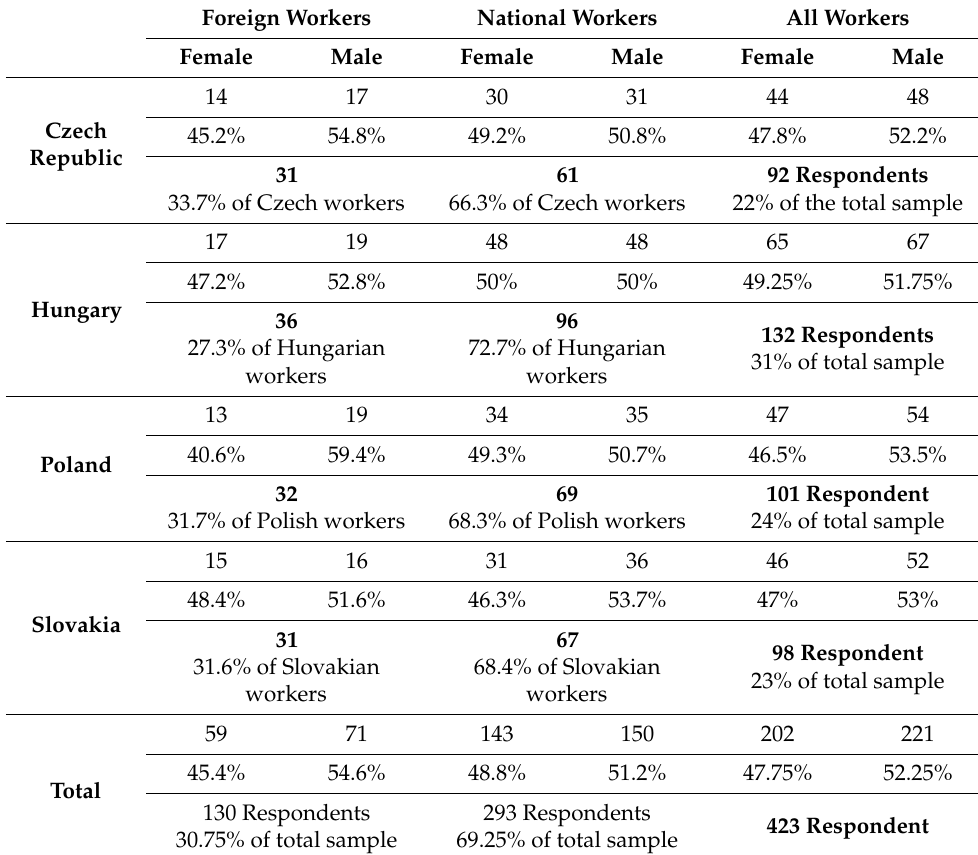
Table 1. Gender and foreign/national workers distribution of the sample over V4 countries. Foreign Workers National Workers All Workers